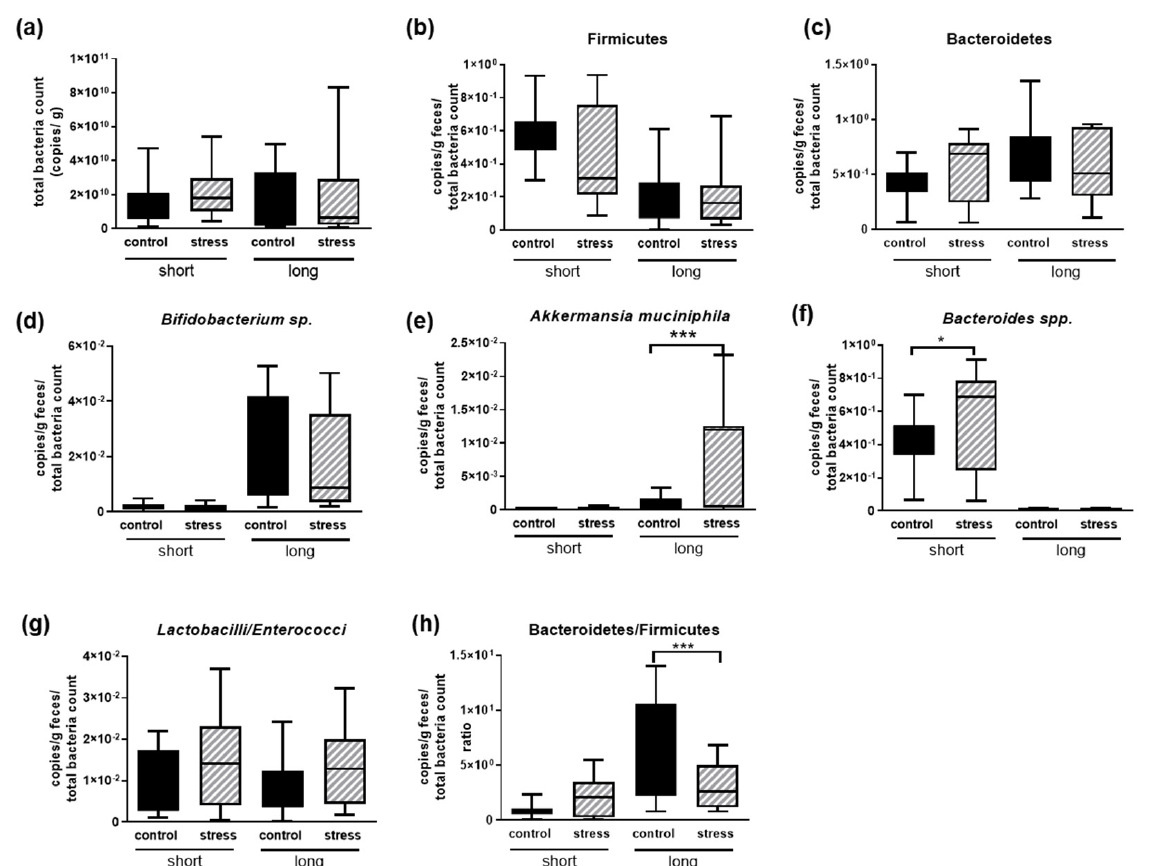
Figure 7. Analysis of microbial composition of feces derived from C57BL6/J OlaHsd female mice after chronic social stress. Feces of animals were collected (n = 12 per group) and analyzed for the following bacterial species and groups: ( a ) total bacteria, ( b ) Firmicutes, ( c ) Bacteroidetes, ( d ) Bifidobacterium sp., ( e ) A. muciniphila , ( f ) Bacteroidetes spp. ( g ) ratio of Lactobacilli to Enterococci and ( h ) Bacteroidetes– Firmicutes ratio. Data are shown with means and min to max. Statistics were performed using one-way ANOVA with Fisher’s LSD test (* p < 0.05; *** p < 0.001). “Short” indicates animal groups that were directly analyzed after having experienced the stress, and “long” indicates groups of animals that were maintained for one year in stable group compositions after the last stress-inducing shuffling of groups.